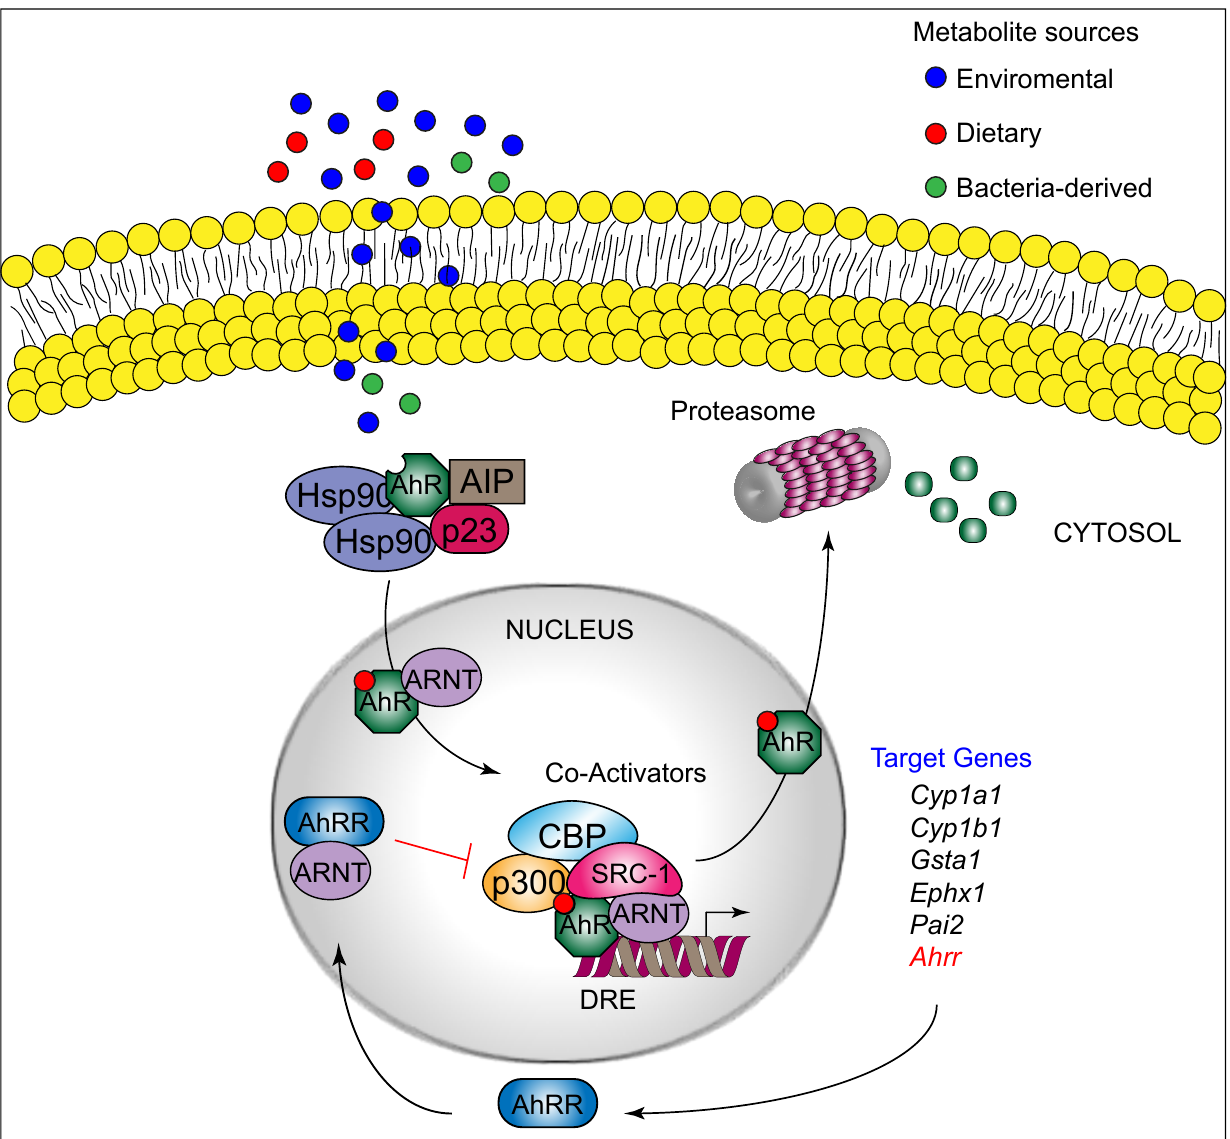
Figure 1. The canonical aryl-hydrocarbon receptor (AhR) pathway. AhR ligands from different sources can cross the plasma membrane and bind to AhR. This allows the translocation of the ligand–receptor complex to the nucleus. In the nucleus, AhR heterodimerizes with its partner ARNT (AhR Nuclear Translocator, also called HIF-1 β ). The heterodimer binds specific DNA regions located in the promoter of target genes, named dioxin response elements (DRE). AhR-ARNT induces the transcription of target genes, including members of the Cyp1a and Cyp1b families, by the recruitment of various coactivators, such as CBP/p300 (cAMP response element-binding protein) and SRC-1 (steroid receptor coactivator 1). AhRR further suppresses AhR transcriptional activity. Then, after being exported out of the nucleus, AhR is rapidly degraded in the cytoplasmic compartment by the